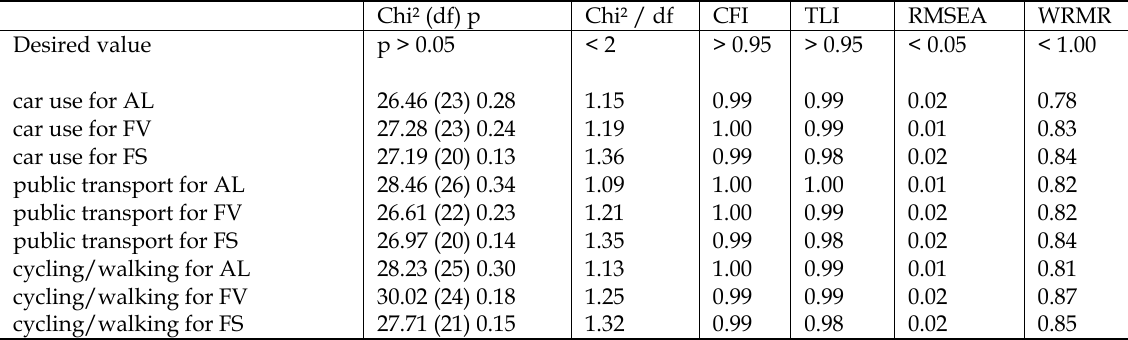
Table 5. Model fit while ignoring subjective